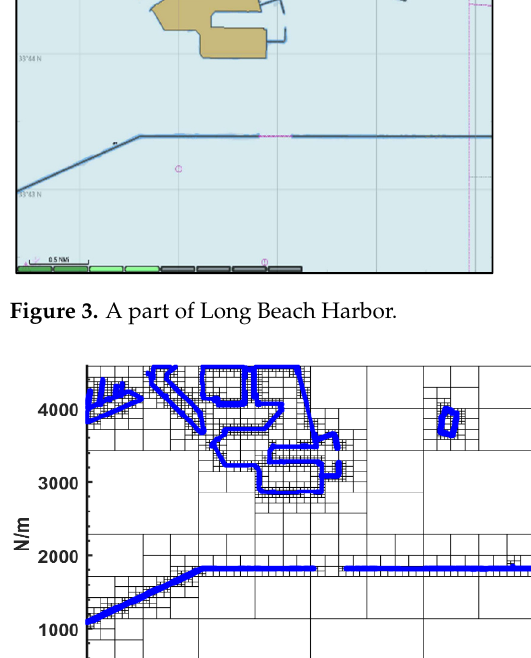
Figure 4. Multi-scale graph with maximum layer depth 7.